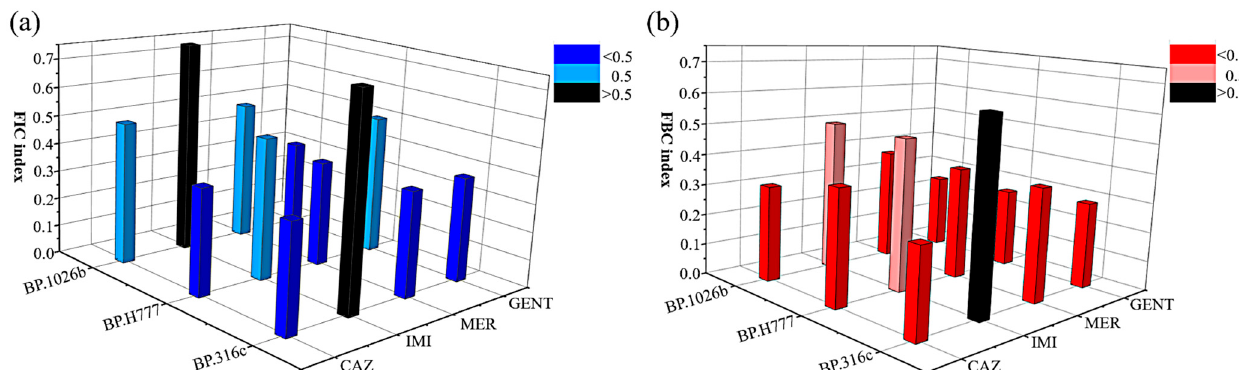
Figure 2. Three-dimensional graphs showing the synergistic antibacterial activity of antibiotics with AgNPs. Comparison of the FIC ( a ) and FBC ( b ) indexes for each of the antibiotics when combined with AgNPs against the three isolates of B. pseudomallei . Synergy was defined as the FIC or FBC index values ≤ 0.5; antagonism was defined as the FIC or FBC index values > 4; and indifference was defined as the FIC or FBC index values > 0.5 and ≤ 4. The data represent three independent experiments that all gave identical values, and no standard deviation was observed.